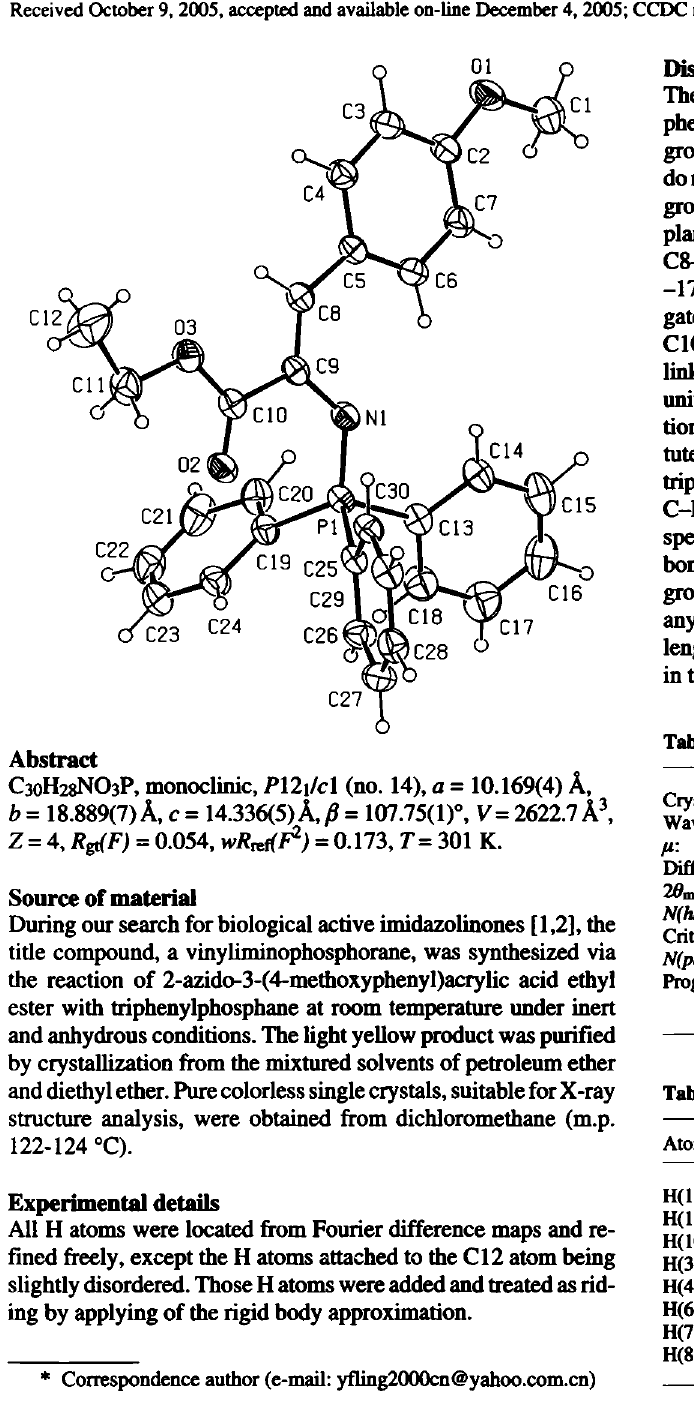
Table 2. Atomic coordinates and displacement parameters (in A 2